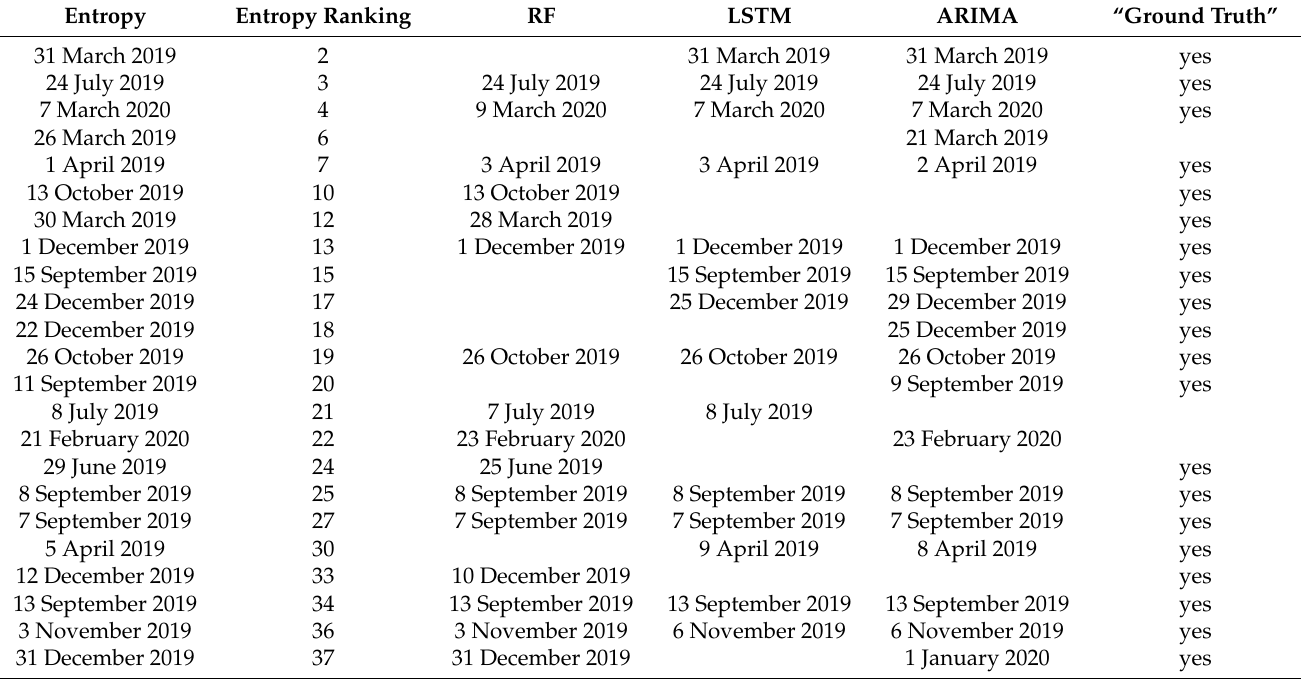
Table 7. Anomalous Days of Household